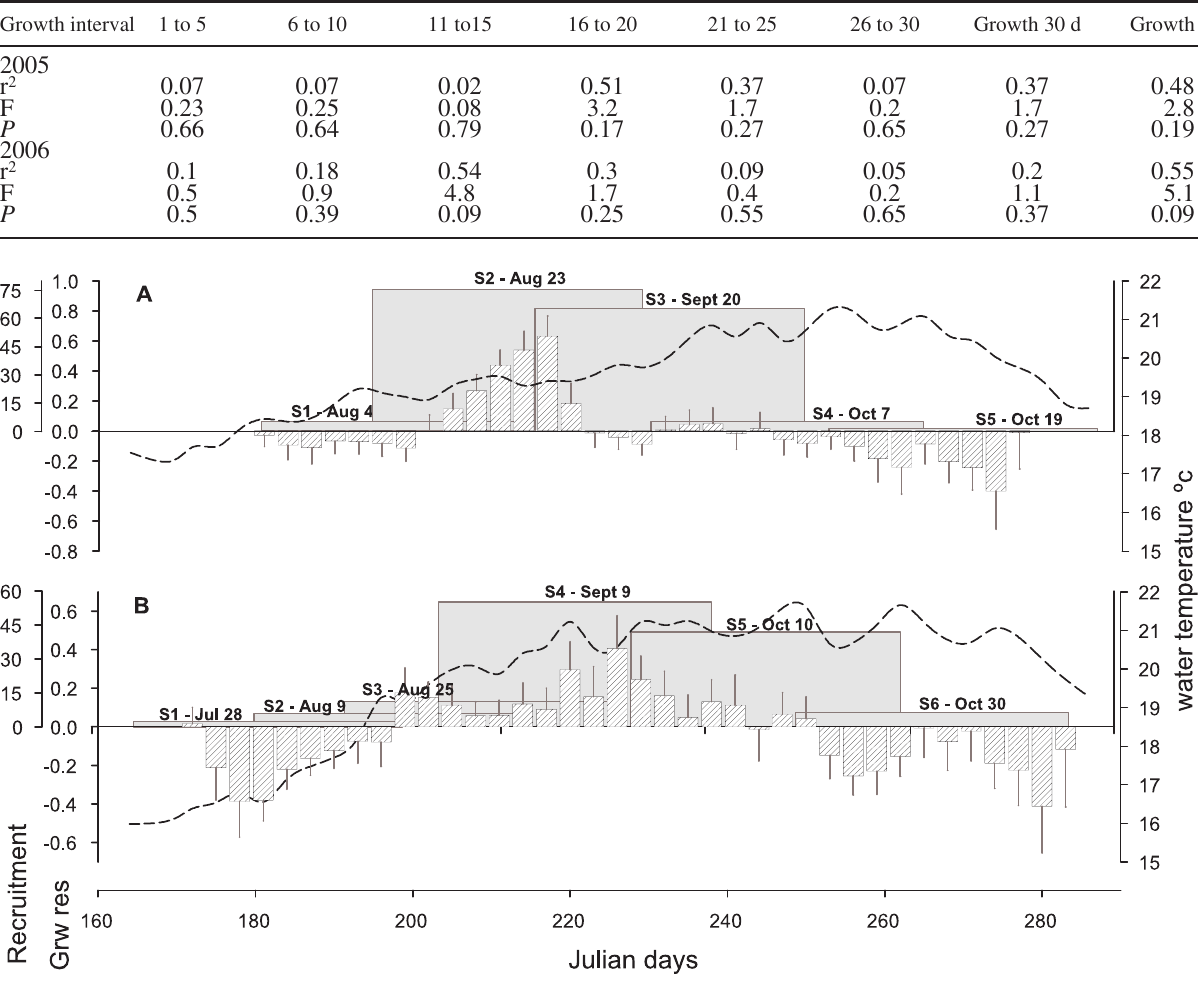
Fig. 5. – Coris julis larval average daily growth residuals at date during first 30 days in the plankton. The height of gray boxes is proportional to recruit magnitude measured each survey, in number of fish / transect (short left axis). The box widths span 30 days on the xx axis. The left side of each box is placed on the modal hatch date of recruits collected on that survey. The dashed line represents daily average water tem- perature at 25 m. Panel A = 2005 and panel B = 2006. Abbreviations, Grw res – Growth residuals. See text for calculation of growth residuals.